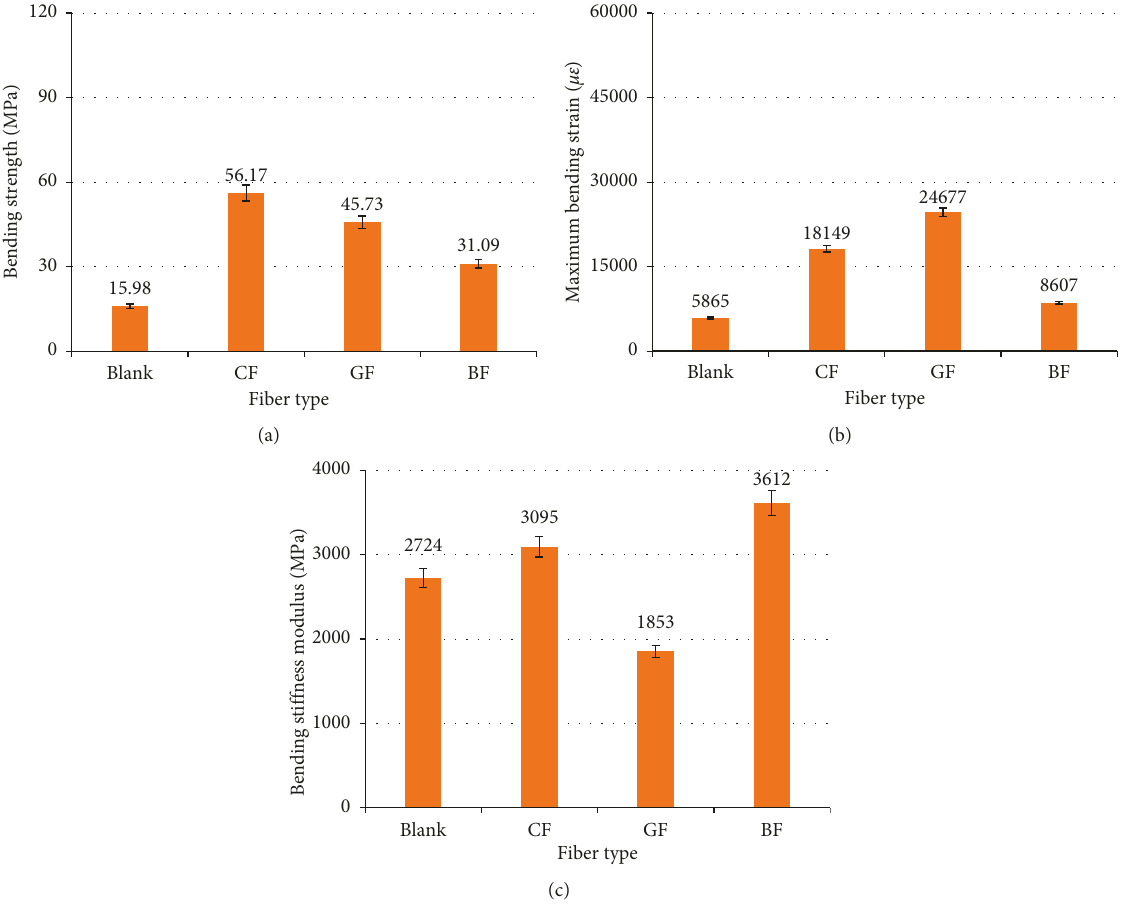
Figure 15: Bending test results at low temperature. (a) Bending and tensile strength at − 10 ° C; (b) the maximum bending and tensile strain at − 10 ° C; (c) bending stiffness modulus at − 10 °